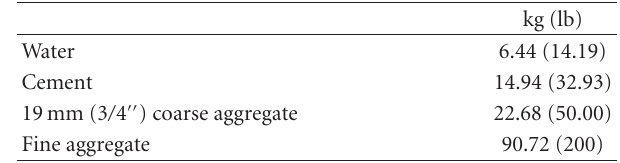
Table 5: Type II Portland cement concrete mix design weights